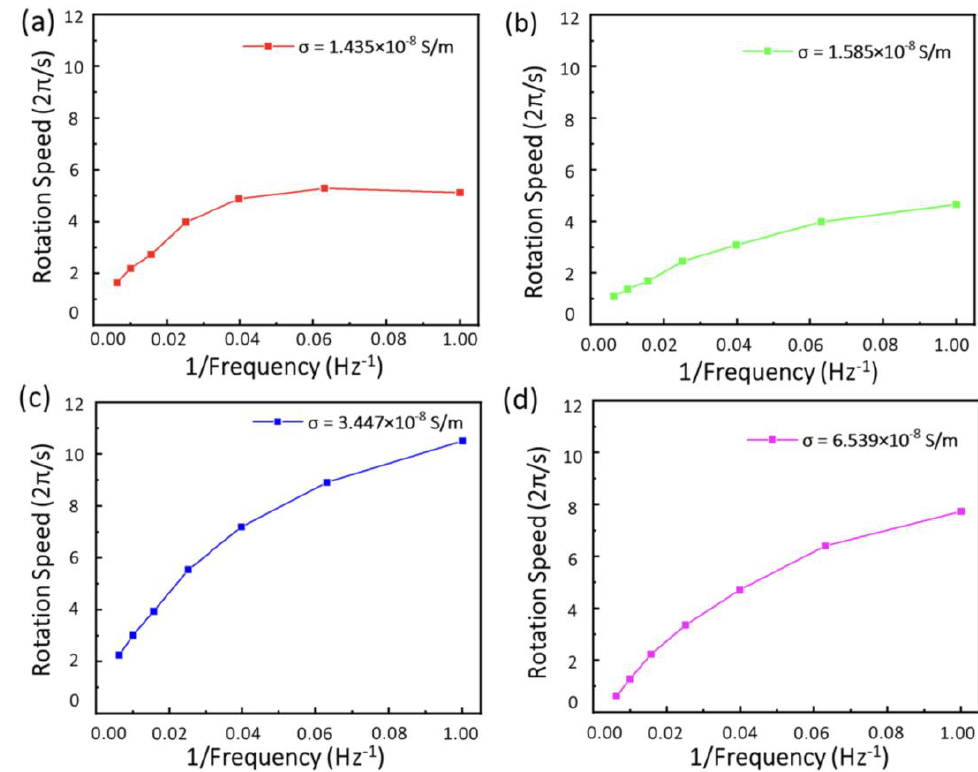
Figure 5. ( a – d ) Rotation speed dependent on AC frequency of the CsPbBr 3 microplates with different sizes in the range from 690 µm 2 , 720 µm 2 , 1040 µm 2 to 1470 µm 2 .